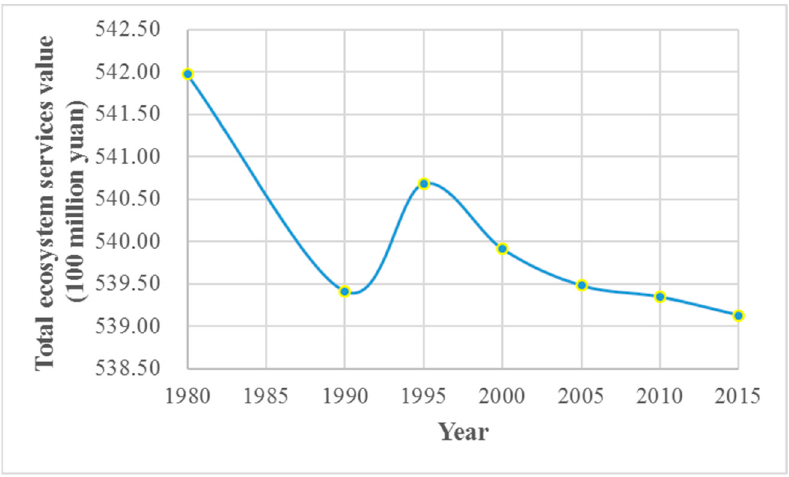
Figure 2. The total ecosystem service value in the Poverty Belt around Beijing and Tianjin from 1980 to 2015 (unit: CNY 100 million).